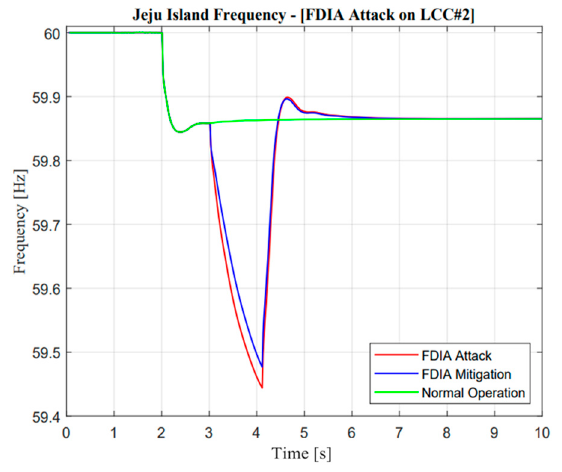
Figure 28. Jeju Island frequency in the false data injection attack operation.